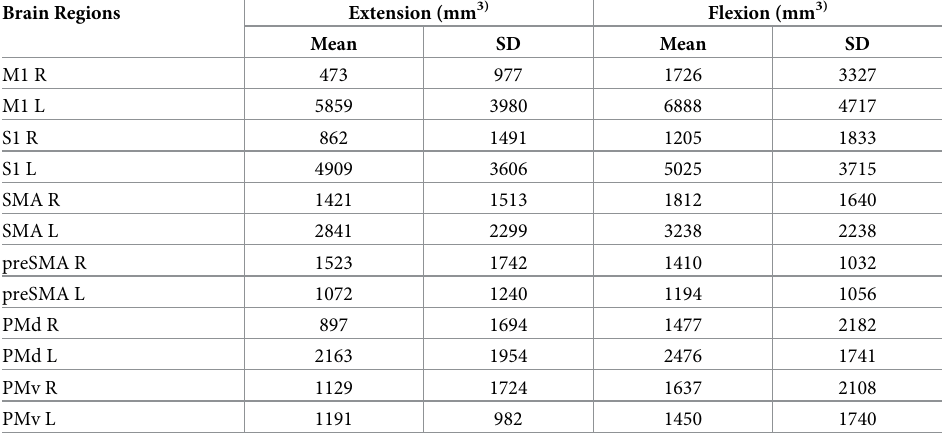
Activations were assessed using a cluster forming threshold of p < 0.001 uncorrected, FWE p < 0.05 cluster size correction for wrist extension > rest and wrist flexion > rest contrasts. Brain ROIs are from the Human Motor Area Template. In all ROIs except preSMA in right hemisphere, mean activation volumes for flexion